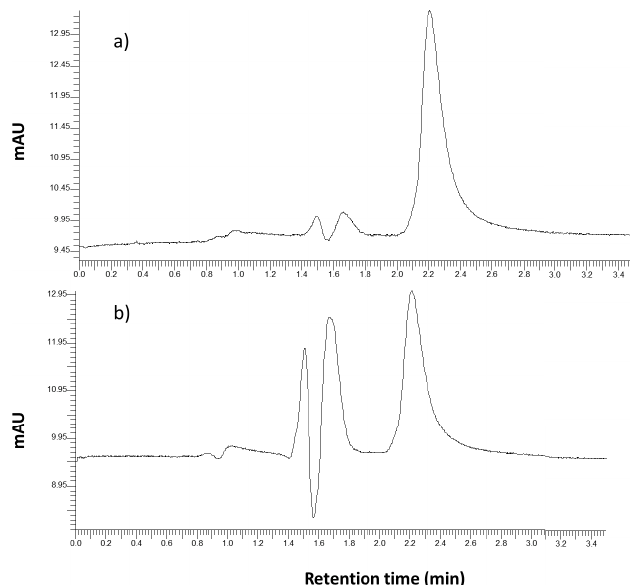
Fig. 4: Chromatograms of pure rebaudioside A (a) and nopal fl akes of O. fi cus-indica cv. Atlixco, sweetened by immersion in a rebaudioside A solution (6 g L -1 ) Tab. 3: Concentration of rebaudioside A incorporated to nopal fl akes of O. fi cus-indica cv. Atlixco after being submerged in different solu- tions of rebaudioside A.